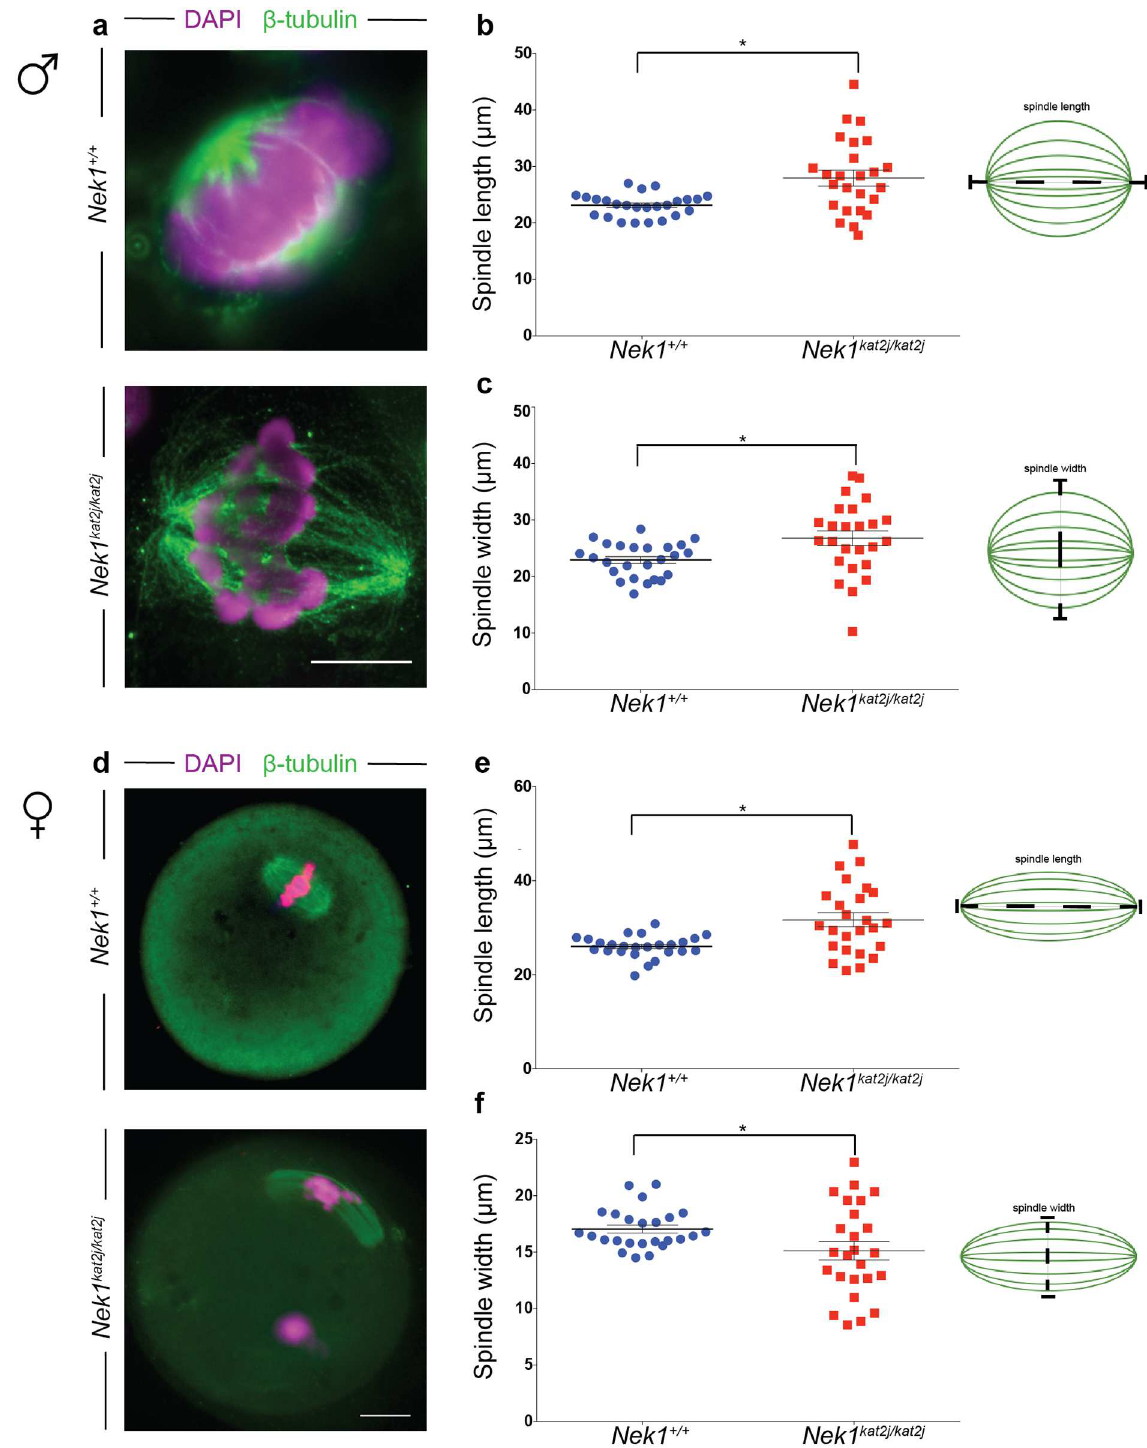
Fig 3. Lack of NEK1 results in abnormal meiosis I spindle morphology in spermatocytes and oocytes. (a) Immunofluorescence (IF) against β -tubulin(green)and DNA stainingwith DAPI (magenta) showinga wildtype(top) and Nek1 kat2j/ kat2j spermatocytes (bottom), along with measurements of spindlelength (b) and width (c). Black bars are means ( μ m) ± Standard deviation. (d) Immunofluorescence (IF) against β -tubulin(green) and DNA stainingwith DAPI (magenta) showinga wildtype(top) and Nek1 kat2j/kat2j (bottom) oocytes, along with measurements of spindlelength(b) and width (c). Black bars are means ( μ m) ± Standarddeviation. * Indicates statistically significantdifferences(Unpairedt-test p < 0.05). https://doi.org/10.1371/journal.pone.0185780.g003 PLOS ONE | https://doi.org/10.1371/journal.pone.0185780 October 5,